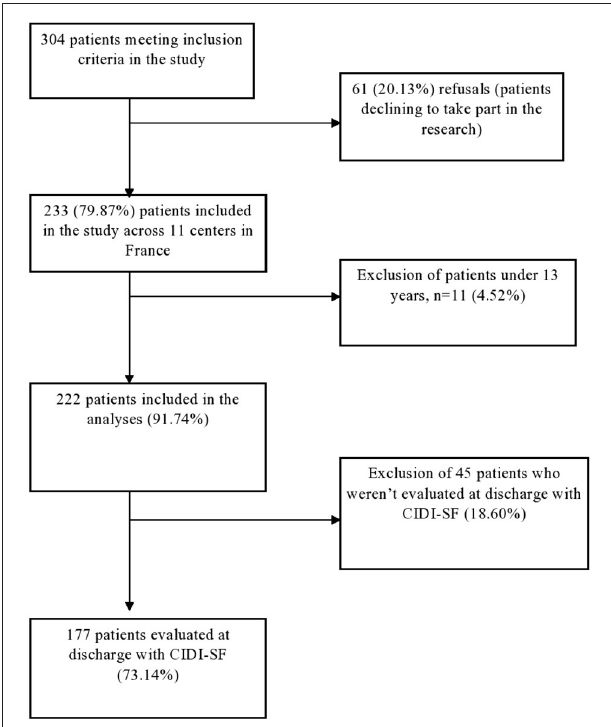
FIGURE 1 | Flow chart. CIDI, Composite International Diagnostic Interview.